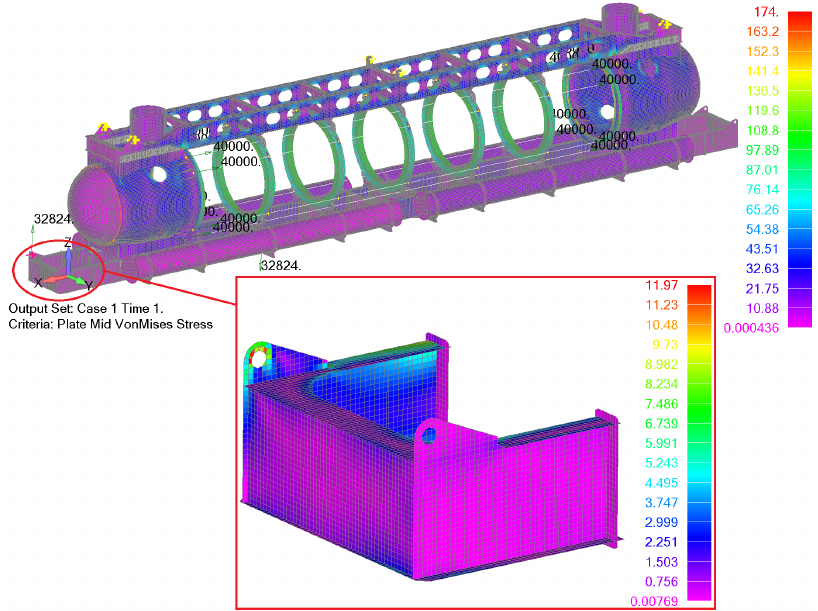
Figure 17. Mid-plate von Mises stresses (in MPa) for emergency lifting in the damaged condition.